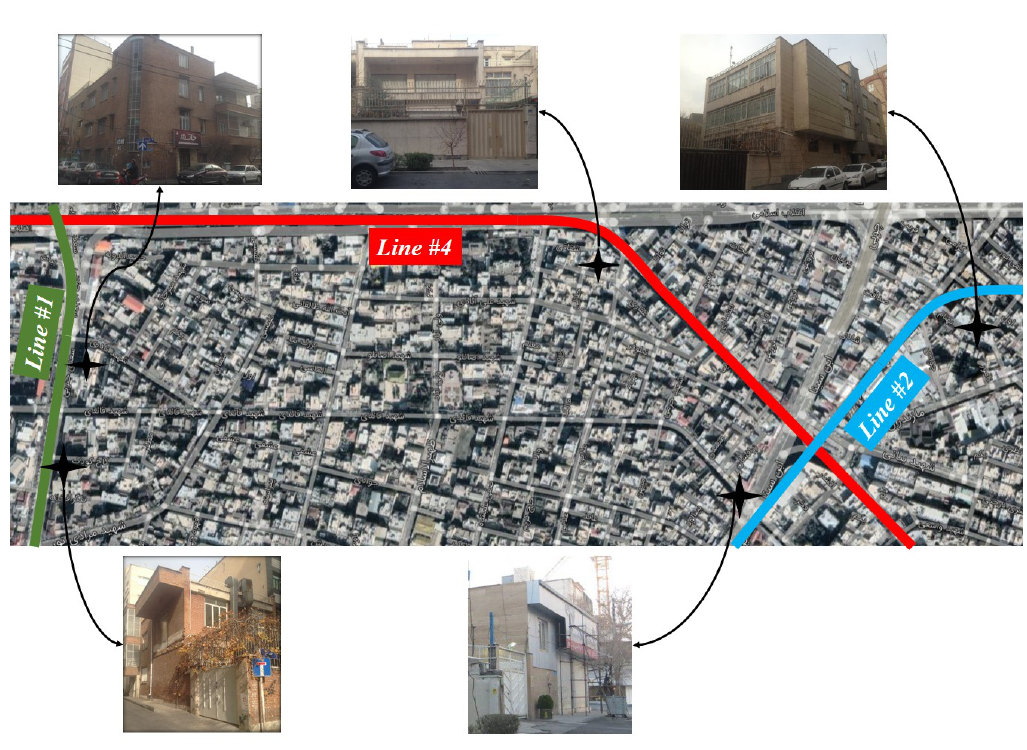
Figure 3: Density of buildings in vicinity of subway lines and five examples of old masonry